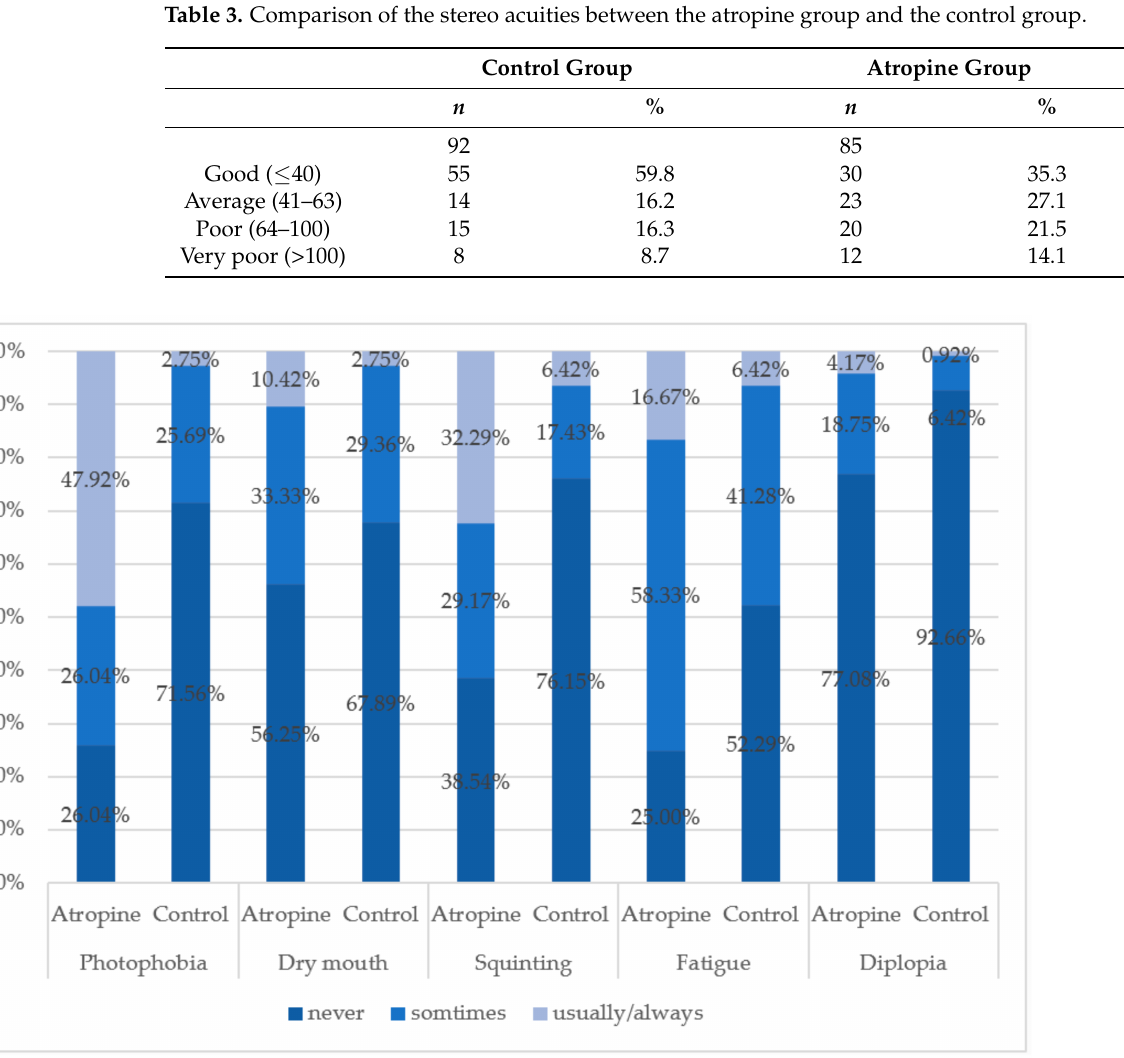
Figure 2. The frequencies of the five major atropine administration-induced side effects between the atropine group and the control